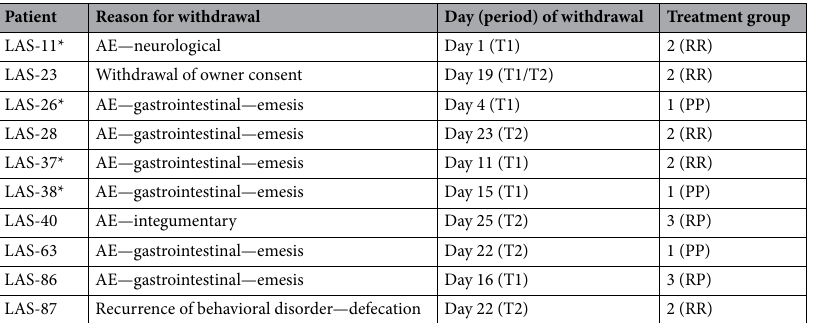
Table 2. Table detailing patients exiting the study early, with reason for withdrawal, study day of withdrawal, and treatment group. LAS patient identification code corresponding to patients enrolled at North Carolina State University, AE adverse event, T1 treatment period 1, T2 treatment period 2, P placebo, R robenacoxib. *Excluded from the PP analysis due to significant deficiencies in